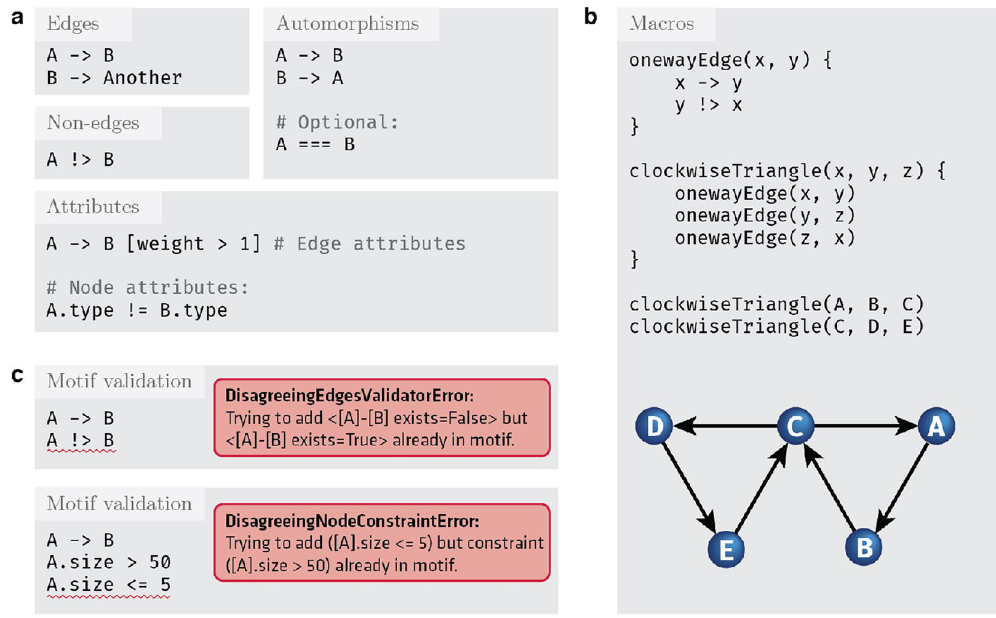
Figure 7. Examples of the DotMotif query language. ( a ) Features of the DotMotif domain-specific language syntax. Nodes are connected by directed edges, notated with an arrow operator. A user can specify